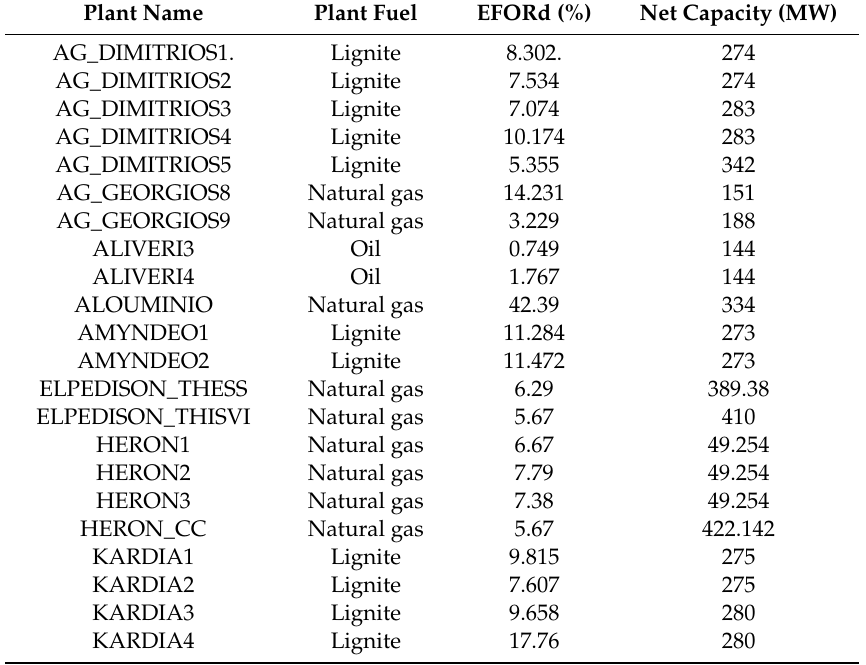
Table A5. The fossil-fueled power plants in the Greek electricity market during the period of 2009–2013 (as accessed at http: // www.admie.gr / fileadmin / groups / EDRETH / CAM /